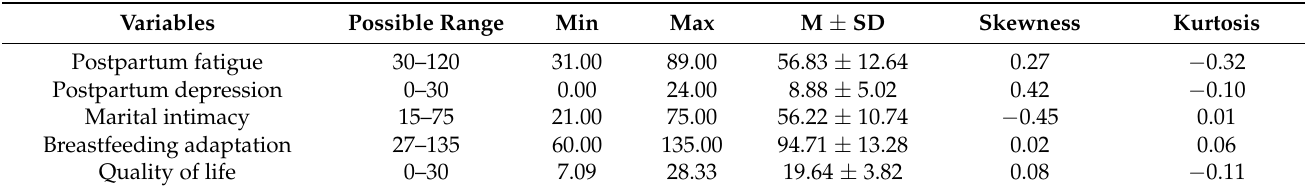
Table 2. Scores of Postpartum Fatigue, Postpartum Depression, Marital intimacy, Breastfeeding adaptation and Quality of life.